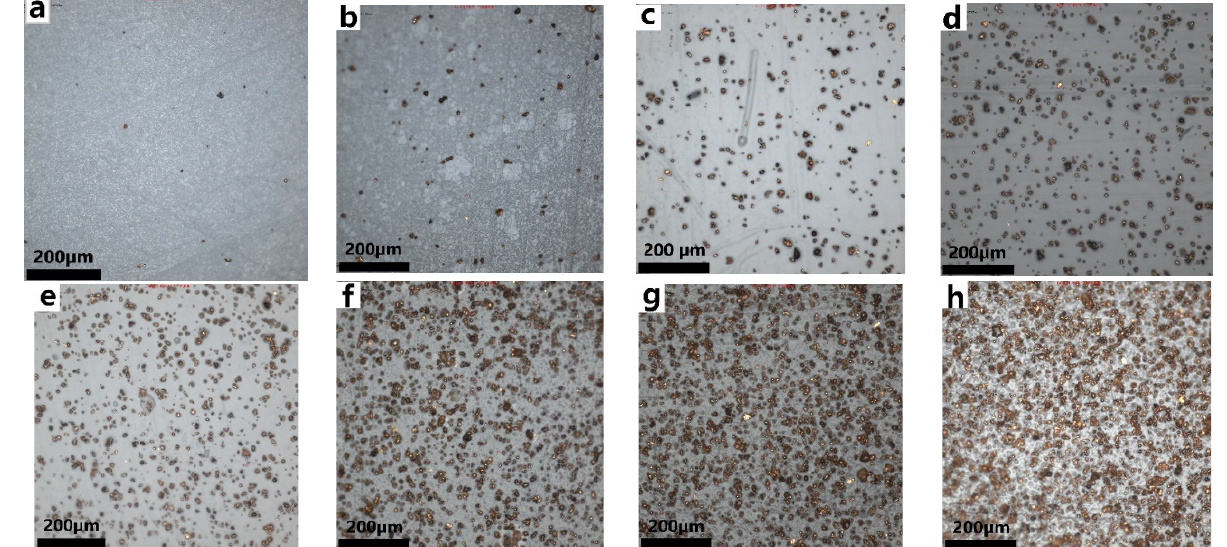
Figure 7. Optical microscopy images showing different content of Cu particles dispersed in PU: ( a ) 0.55 vol.%, ( b ) 1.2 vol.%, ( c ) 2.6 vol.%, ( d ) 4.3 vol.%, ( e ) 6.6 vol.%, ( f ) 9.5 vol.%, ( g ) 14 vol.% and ( h ) 20